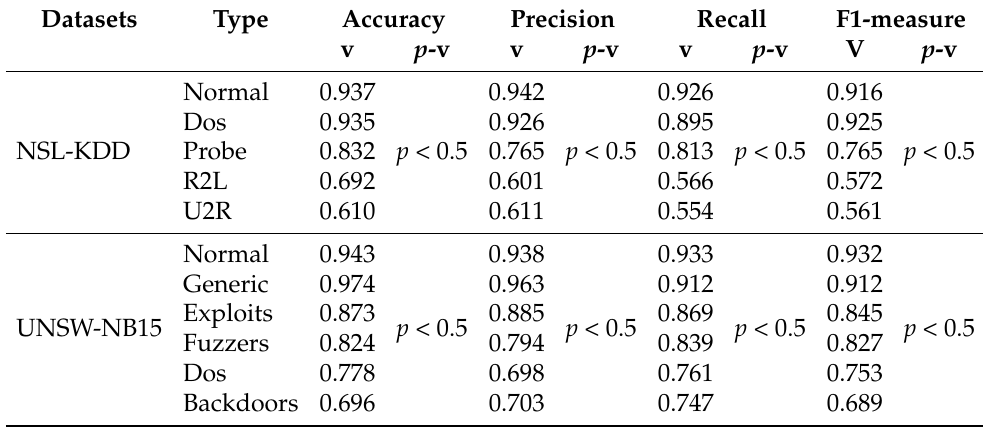
Table 5. Performance of IDD on rare class classification (v: value; p -v: p -value).